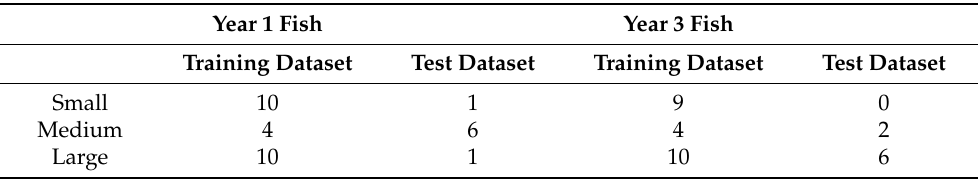
Table 1. The number of fish in the small, medium, and large categories for the year 1 and year 3 fish in the training and test